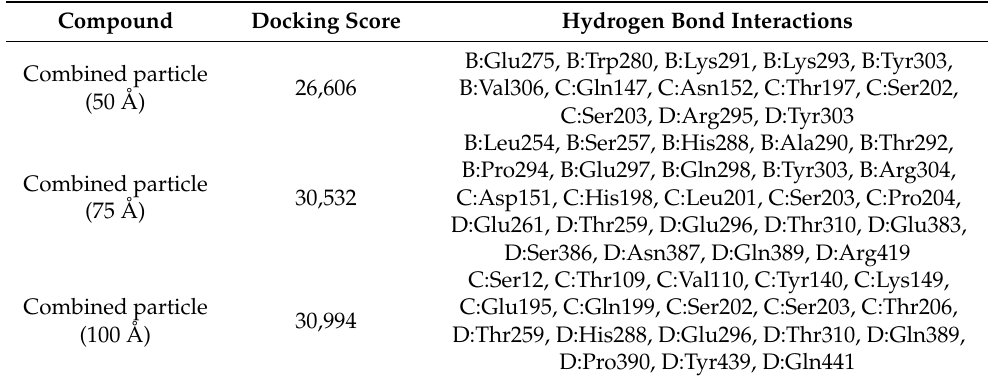
Figure 3. Combined particle-size variation conjugated to trastuzumab: ( a ) 50 Å, ( b ) 75 Å, ( c ) 100 Å, and ( d ) the regional structure of trastuzumab. Table 4. Hydrogen bond interactions of amino acid residues in trastuzumab with combined particles of α -mangostin and chitosan at the conjugation